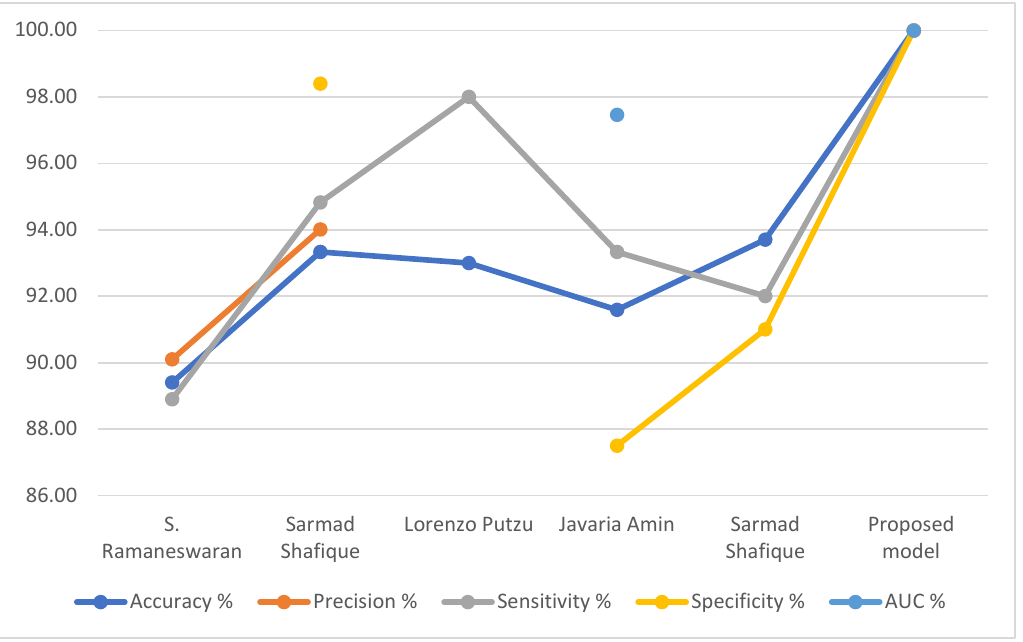
Figure 30. Comparing the performance of our proposed system with the previous systems.